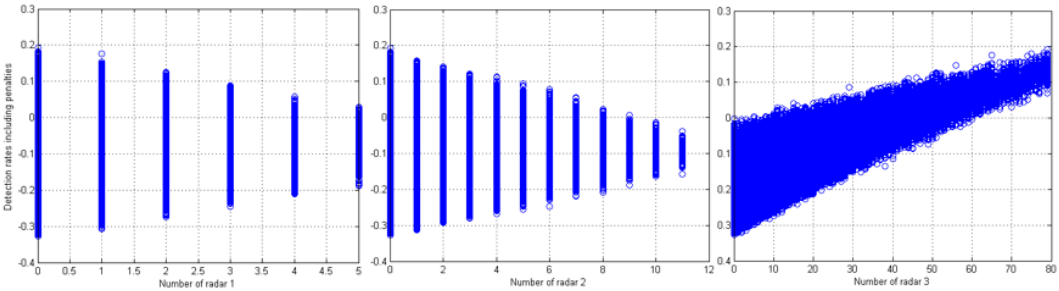
Figure 6. Detection rates including penalties ( y axis) by number of each radar ( x axis).